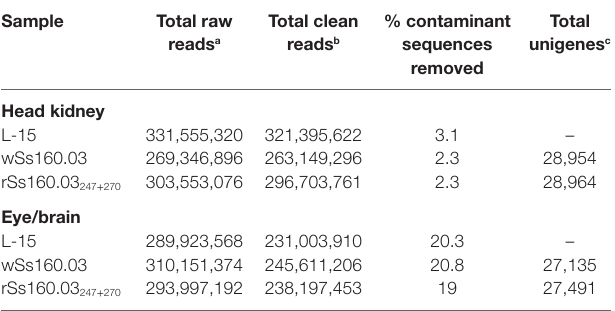
Table 1 | Illumina sequencing analysis of tissue Senegalese sole samples infected with nervous necrosis virus reassortants, and L-15-control group, at 48 h